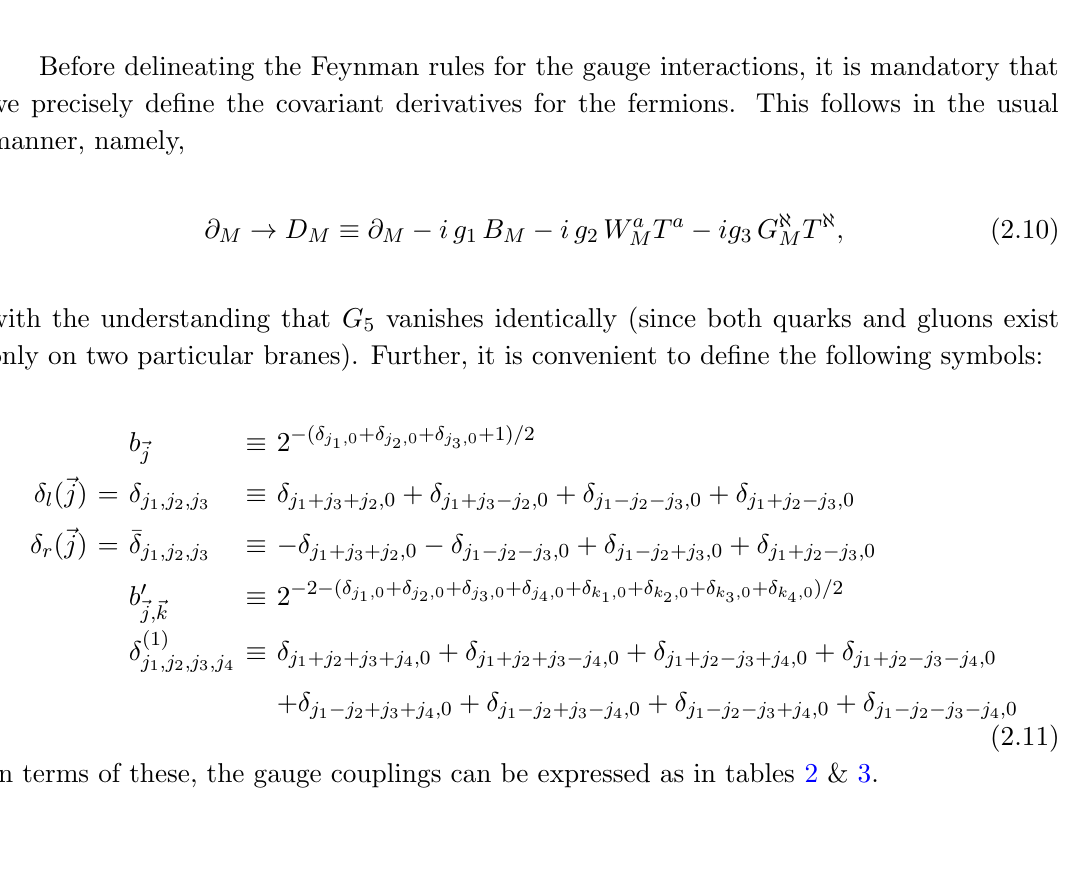
Table 3 . Interactions of bulk gauge boson and fermion with Higgs (cid:12)eld in the